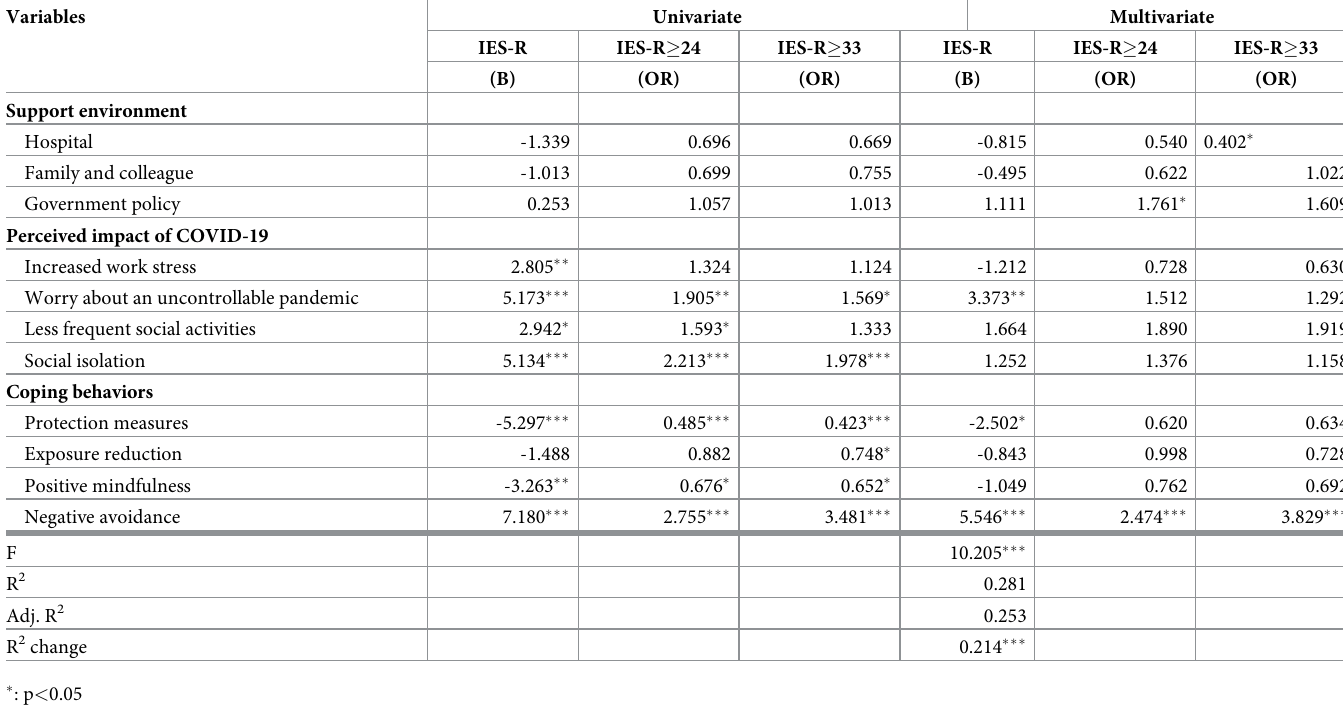
Table 6. The association of support environment, perceived impact, coping behaviors, and IES-R.